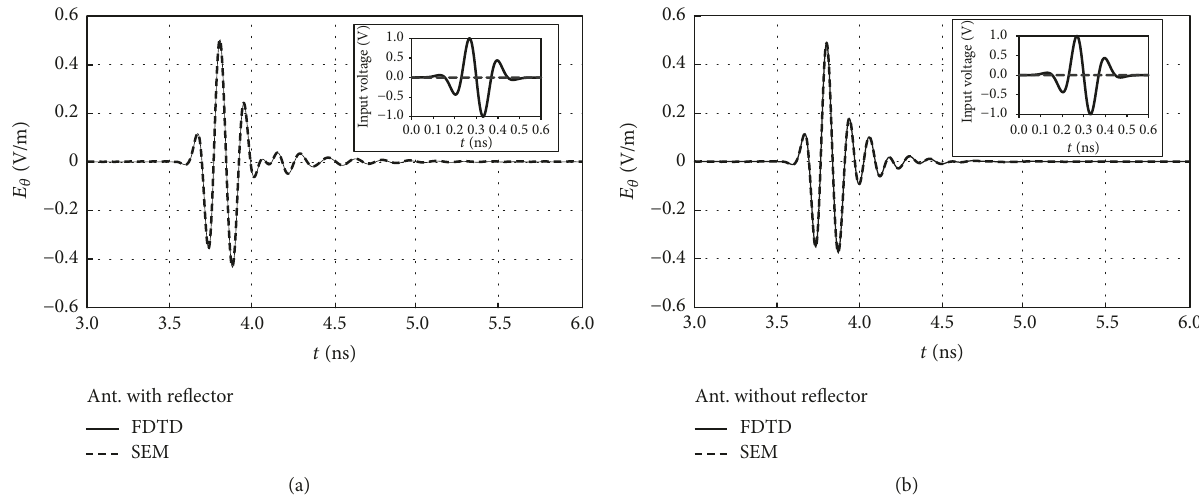
Figure 15: Time-domain antenna response computed at 𝑥 = 1 m along the boresight of the drop-shaped antenna (a) with reflector and (b) without reflector. The migration of some poles towards higher frequencies is responsible for a larger ripple level in the late-time response of the antenna equipped with the metal